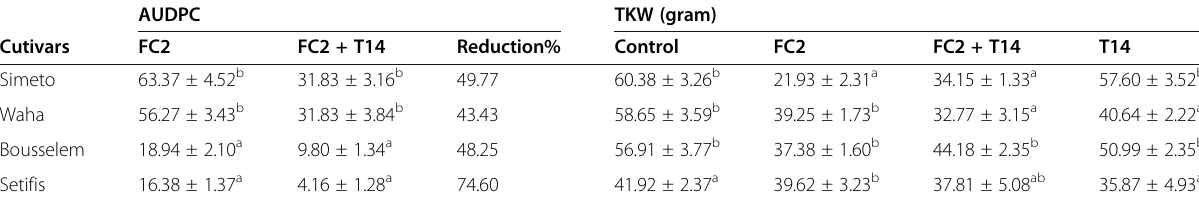
Table 4 Biocontrol of T14 on FHB tested on 4 durum wheat cultivars, by the AUDPC standard (FC2, FC2 + T14, %reduction), and TKW (control, FC2, FC2 + T14, T14)